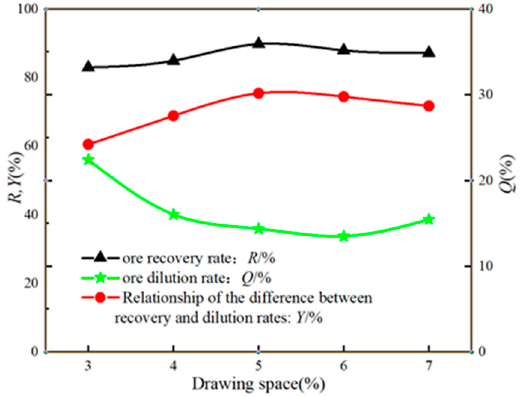
Figure 17. Relationship between recovery indexes and drawing space from an overall perspective.